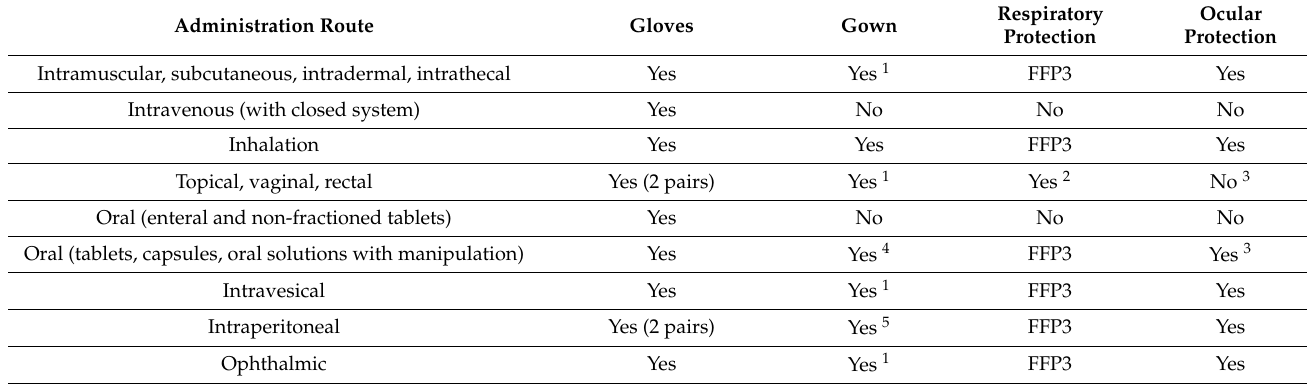
Table 3. Characteristics of personal protection equipment according to the risk of drug